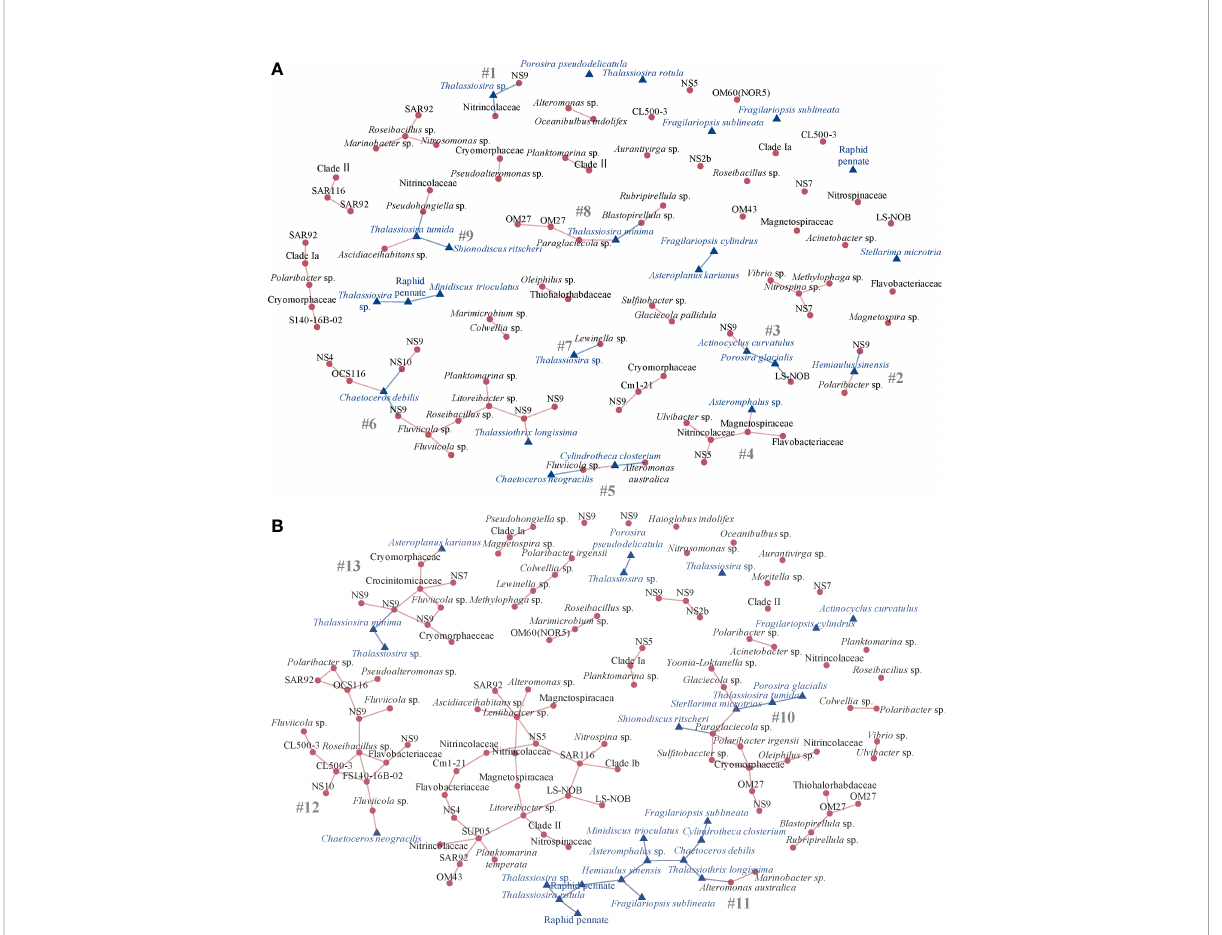
FIGURE 5 SPIEC-EASI network of the top 100 bacterial amplicon sequence variants (ASVs) and 25 diatom ASVs by relative abundance at the (A) Drake Passage stations ( n = 6) with subnetworks #1-9 that contain at least one cross-kingdom connection and (B) Gerlache and Brans fi eld Strait stations ( n = 12) from the NBP16-08 cruise with subnetworks #10-13 that contain at least one cross kingdom connection. The stability of each is 0.05. Only positive edges are shown. Each node is an ASV labeled by lowest taxonomic assignment. Red circle nodes are bacteria, and blue triangle nodes are